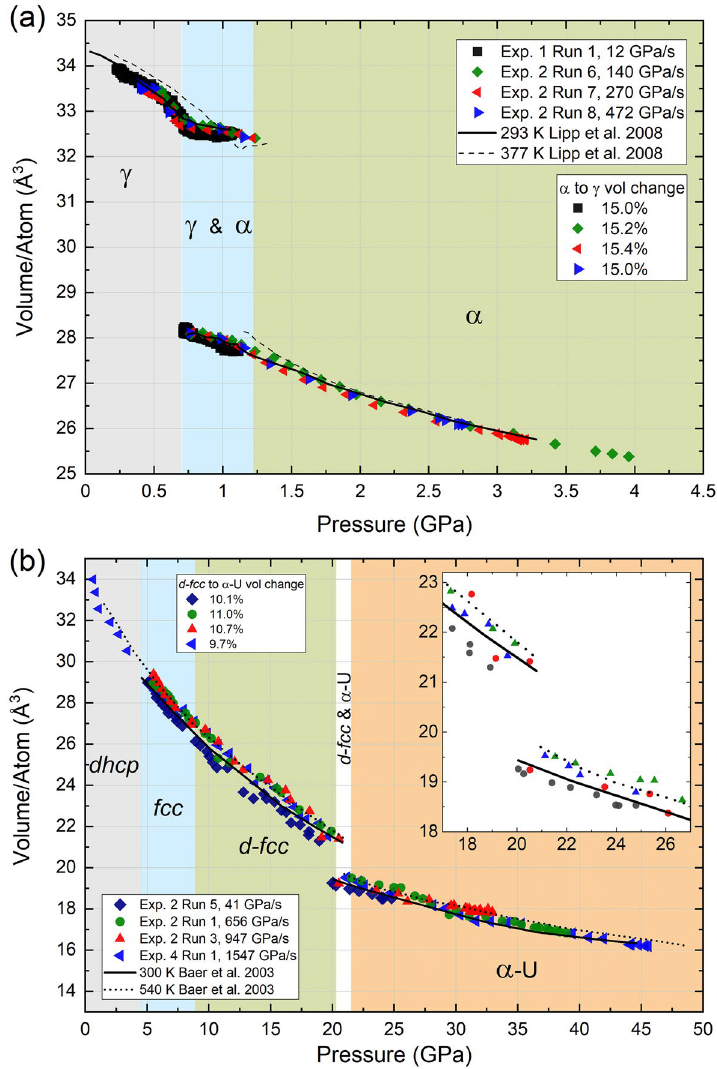
Figure 3. Representative P – V curves collected at various compression rates for ( a ) Ce and ( b ) Pr. Multiple runs at different compression rates are plotted to highlight that there are no systematic changes in the P–V curves collected at different compression rates. Additionally, elevated temperature isotherms are plotted in both panels to assess whether any significant heating of the sample occurs under rapid compression at room temperature in the